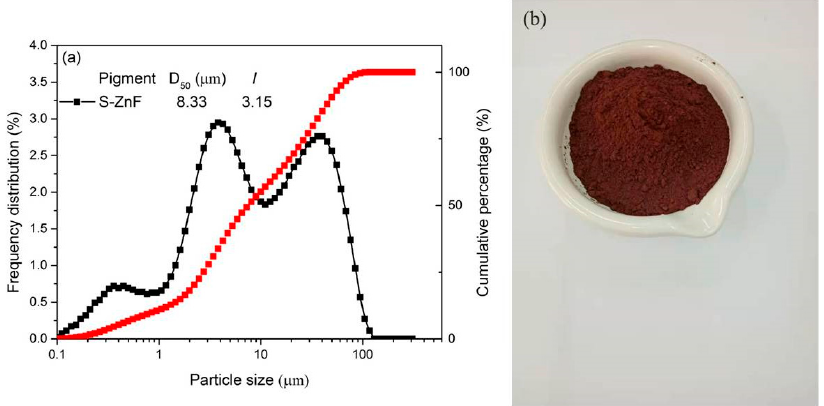
Figure 1. ( a ) The particle size distribution of S-ZnF pigment as a feed sample; ( b ) picture of S-ZnF pigment as a feed sample.